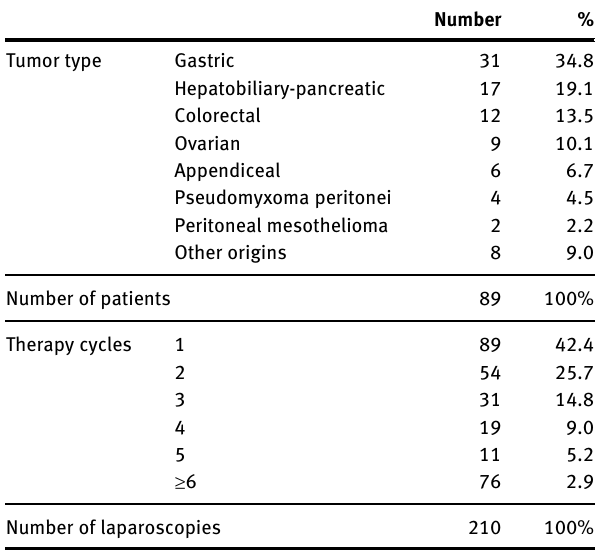
Table  : Tumor histology and therapy cycles.